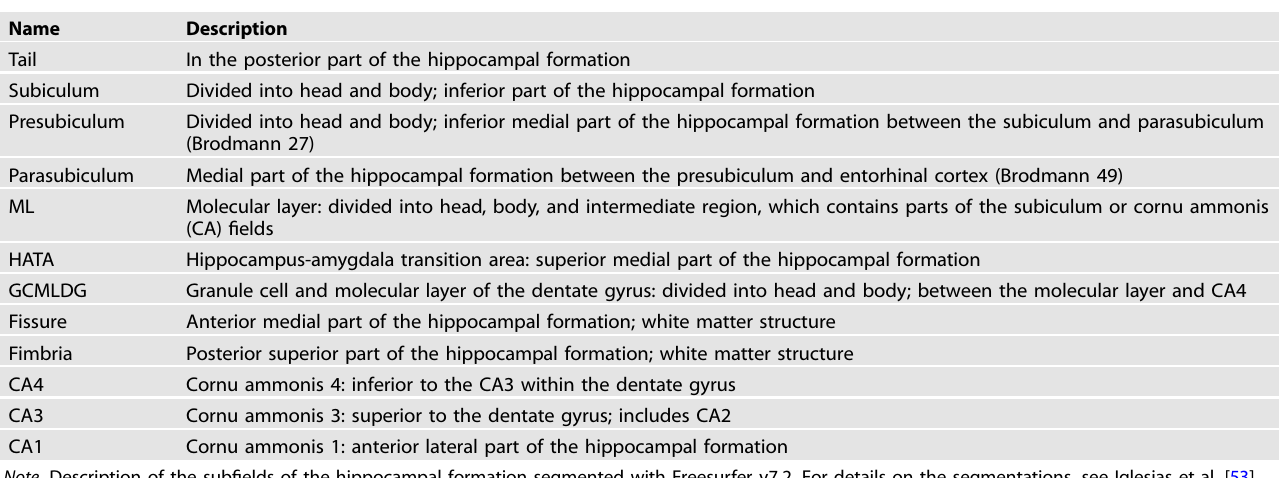
Fig. 1 Hippocampal formation sub fi elds. The hippocampal formation sub fi elds segmented with Freesurfer v7.2 shown in different views. The table is based on Iglesias et al. [53] ML molecular layer, HATA hippocampal amygdala transition area, GCMLDG granule cell and molecular layer of the dentate gyrus, CA cornu ammonis. Table. 1. Sub fi elds of the hippocampal